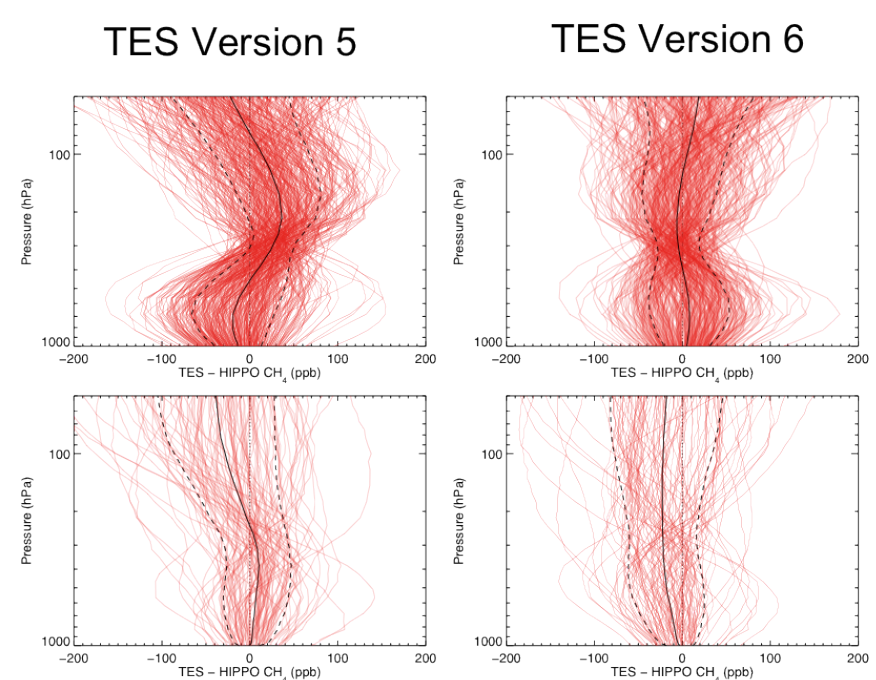
Figure 9. As in Fig. 6, but with the global bias correction (Eq. (7) and Sect. 5.4)